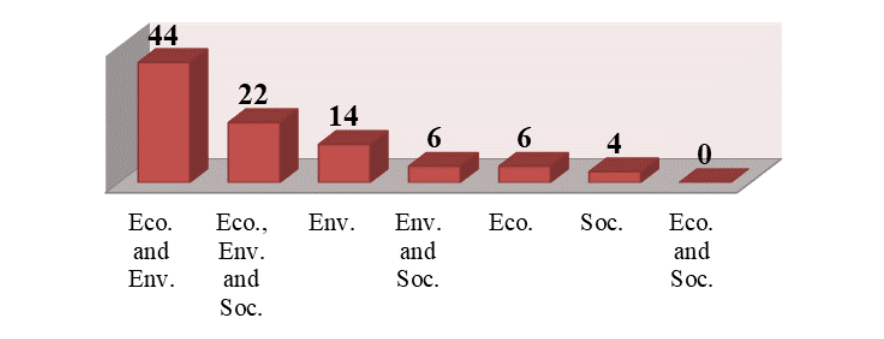
Fig. 1. Literature contributions by sustainable development dimensions in the ninety-six analyzed articles